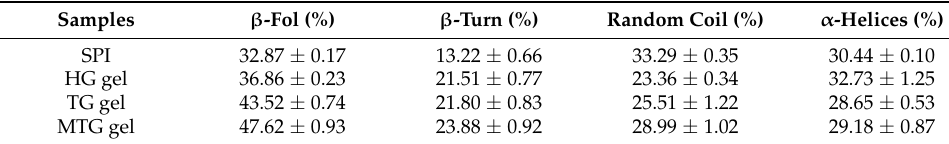
Table 1. Secondary structure content of different gels.